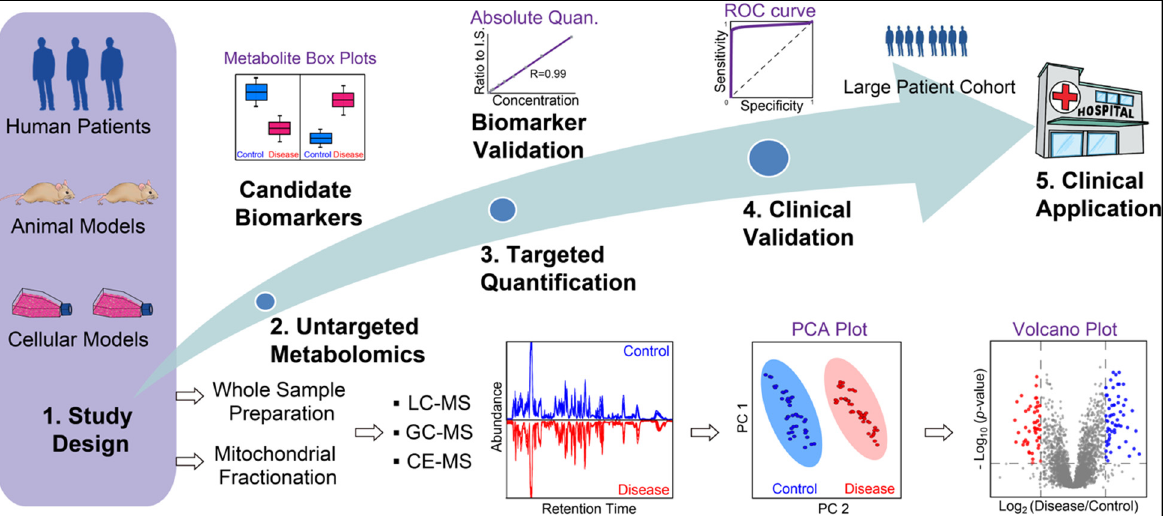
Figure 4. General workflow of MS-based metabolite biomarker discovery for mitochondrial diseases. Whole sample preparation (cell, tissue, and biofluids) and mitochondrial fractionation have been used for metabolomics to study mitochondrial diseases. Untargeted metabolomics is conducted to identify candidate biomarkers, which are then validated by targeted absolute quantification. Next, biomarkers need to be clinically validated with preferably a large patient cohort to examine their sensitivity and specificity prior to their clinical applications.